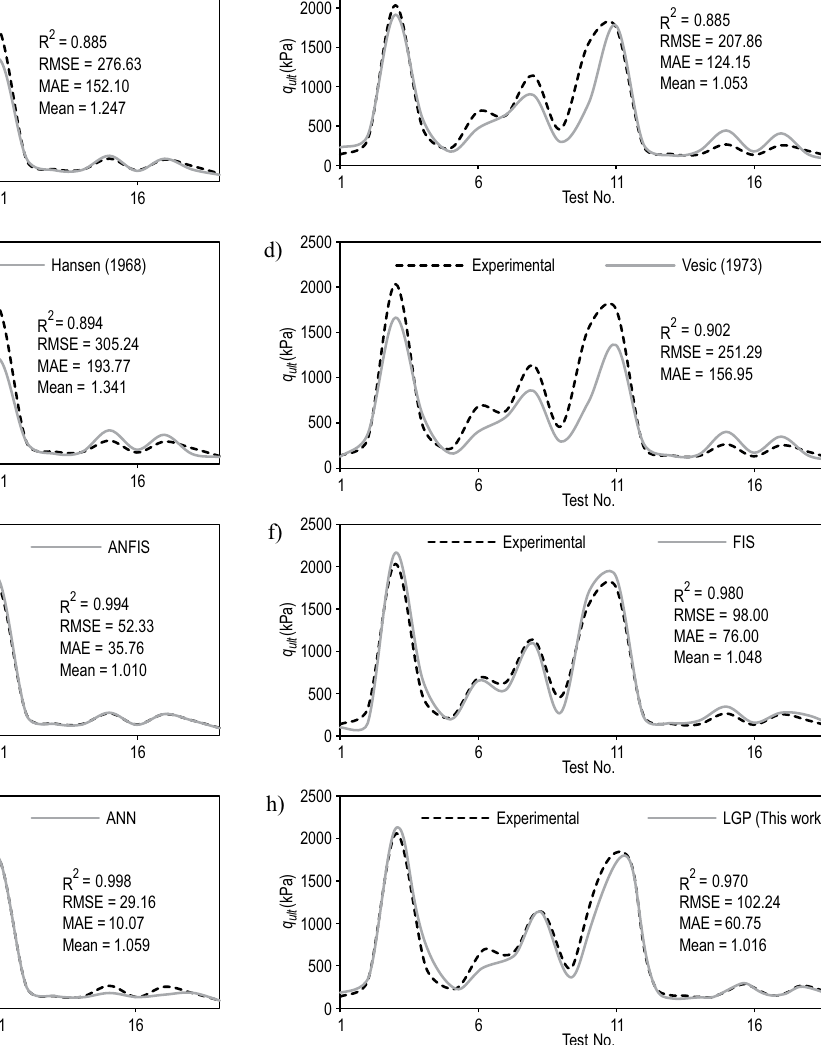
Fig. 8. A comparison of the bearing capacity predictions made by different